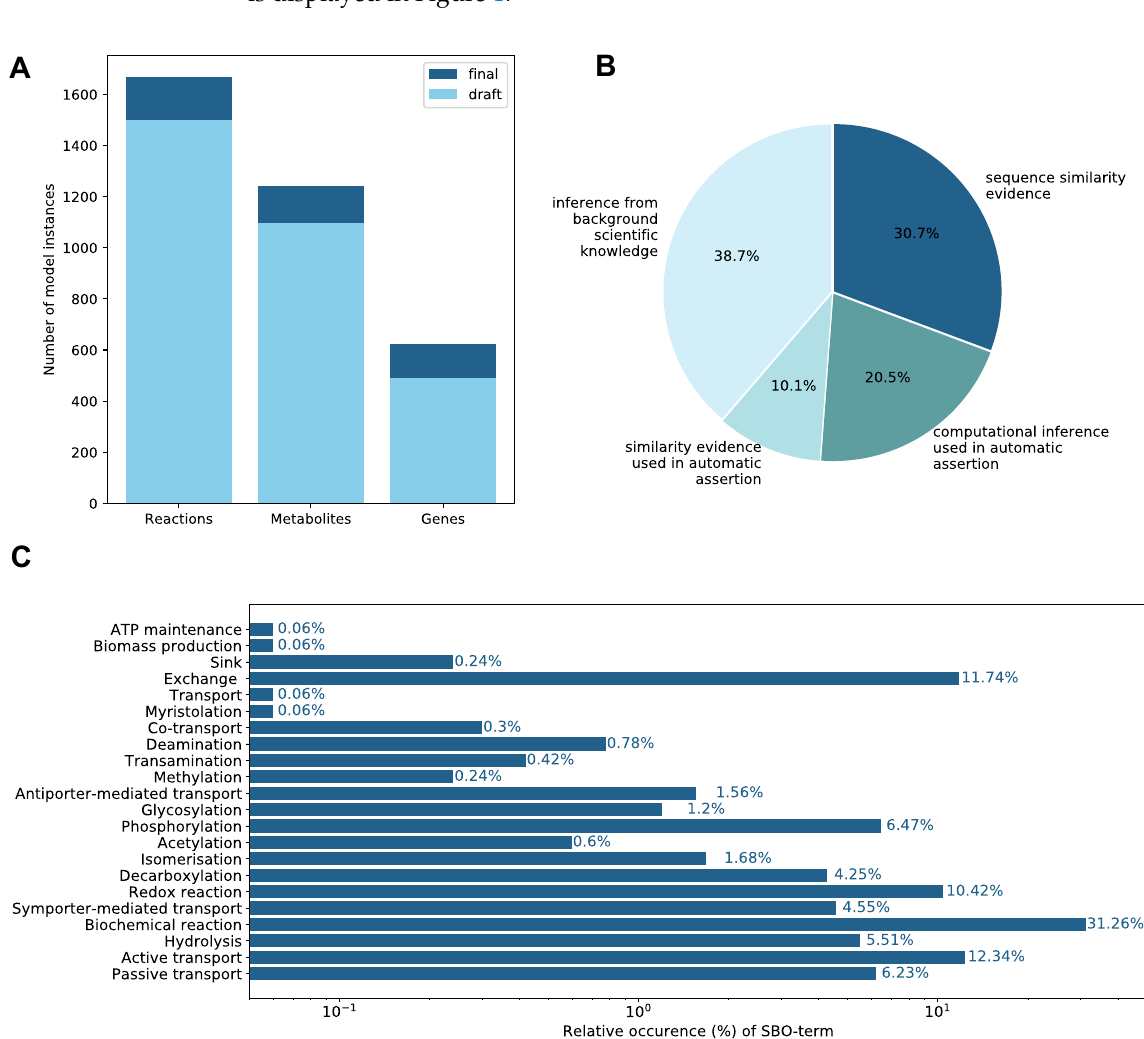
Figure 1. Properties of the genome-scale metabolic model (GEM) i DPM21RW. This figure illustrates various model proper- ties. ( A ) The number of model instances in the draft and the refined final reconstruction is indicated. In total, 132 genes, 169 reactions, and 146 metabolites were added to the final reconstruction. ( B ) Evidence and Conclusion Ontology (ECO) terms indicate the confidence of inclusion for the model’s reactions. Increasing color intensity corresponds to increasing confidence. ( C ) Systems Biology Ontology (SBO) terms were used to annotate the models’ reactions further [57]. The axis of the relative occurrence is given as a log